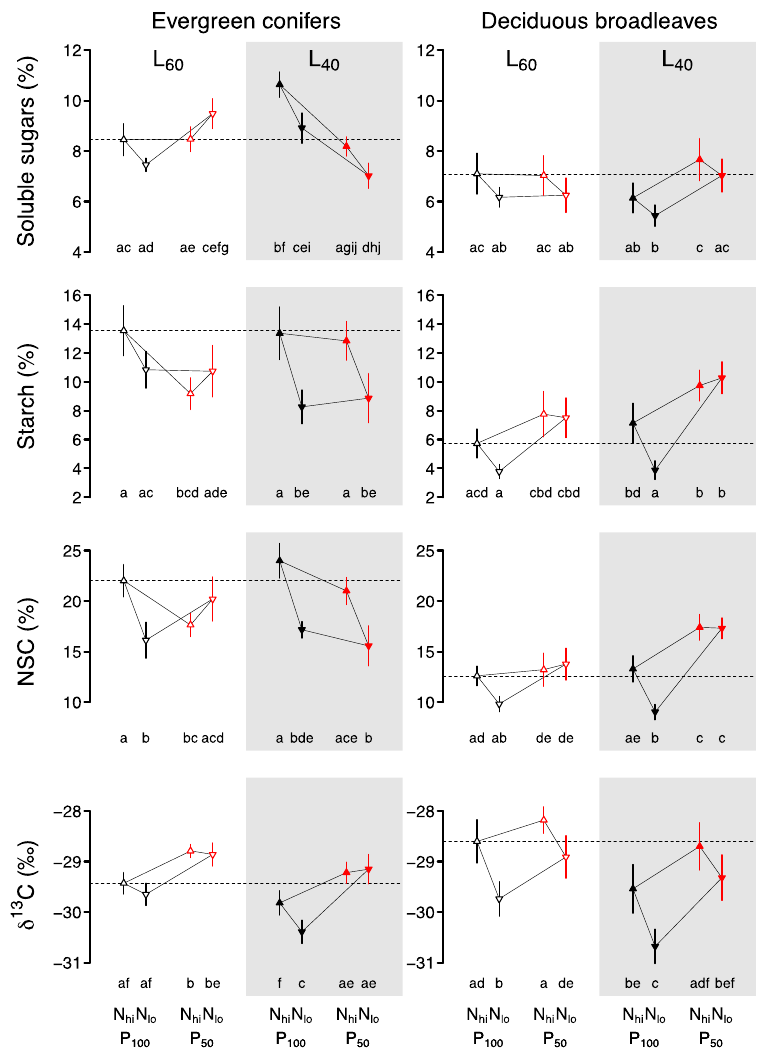
Figure 2. Foliar soluble sugar, starch, total non-structural carbon (NSC) concentration, and carbon isotope fractionation ( δ 13 C; means ± SE) of evergreen conifer and deciduous broadleaved seedlings grown for three years under fully crossed combinations of ambient (P 100 , black symbols) or reduced precipitation (P 50 , red symbols), high (L 60 , open symbols) or low PAR (L 40 , filled symbols), and high (N hi , upwards triangle) or low (N lo , downwards triangle) soil nutrient availability. The dashed line indicates foliar traits under optimal resource availability, i.e., L 60 × P 100 × N hi . Different letters below the means indicate significant differences between treatment combinations within species group (Tukey adjusted least square means).